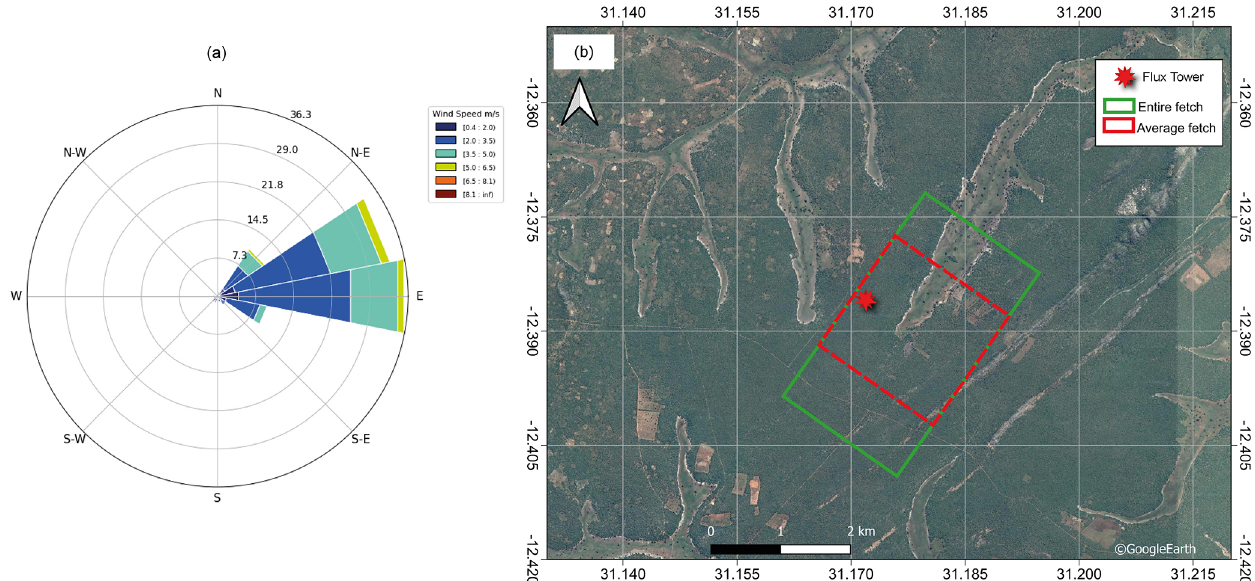
Figure A1. Analysis of the wind direction and wind speed using the wind rose (a) , and the extent of the fetch for the DTS observations (b) based on the wind rose